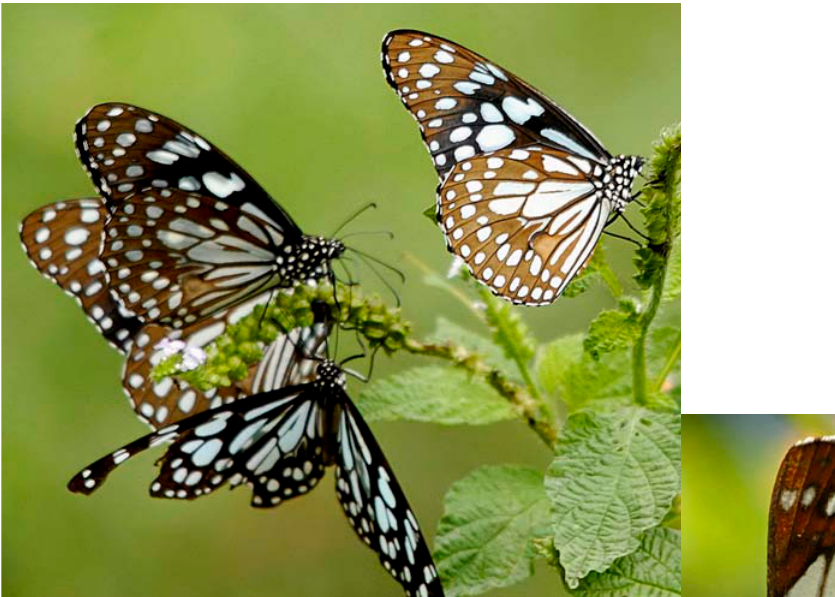
Image 12. Blue Tiger Tirumala limniace